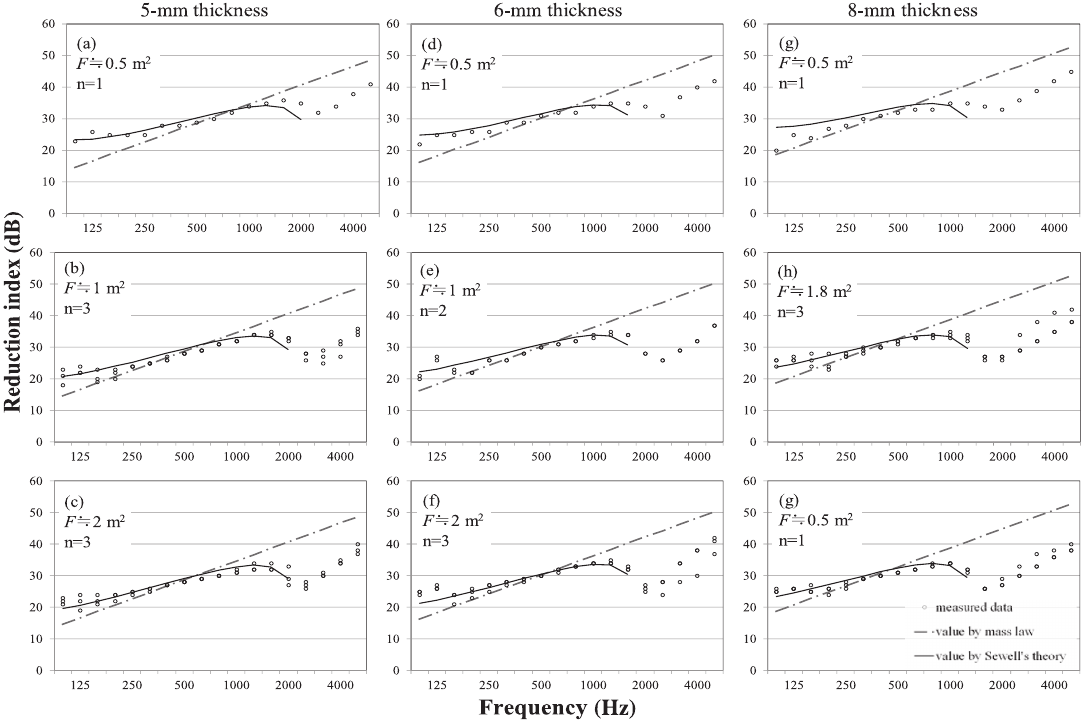
Reduction indices of fixed window with theories. Solid lines and dash–dotted lines, respectively, represent values using Sewell’s theory and values using the mass law. Plots show measured data of windows in the 1/3 octave. ‘F’ and ‘n’ represent the window area and the number of the samples,